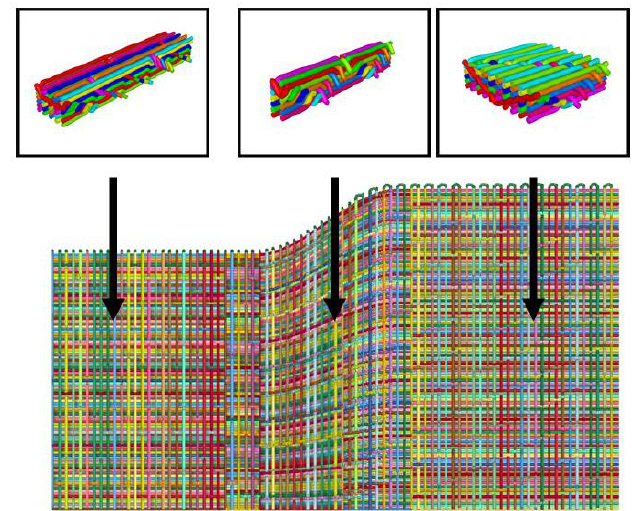
Figure 5. Model of fabric GW1 with gradient structure (one-fourth model), from left to right: layer-to-layer satin weave, layer-to-layer plain weave, angle-through-thickness weave.